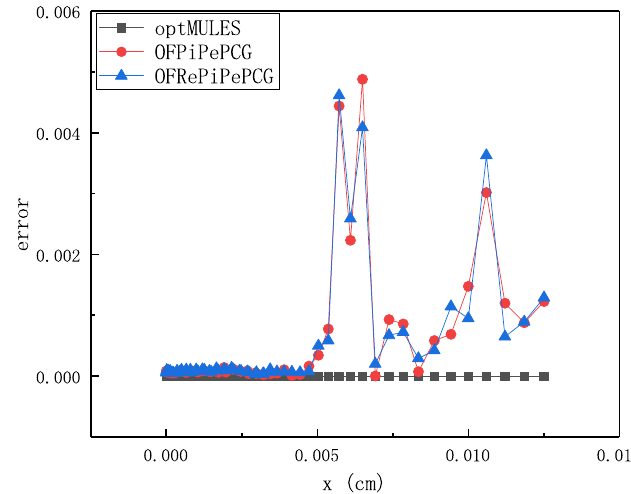
Figure 10. The Relative Error of Final Filed Data. Note that we sample and compare the pressure field data on the head of head-form, which is of great physical significance. The pressure field data is along the surface of head-form with the x -axis ranging from 0 to